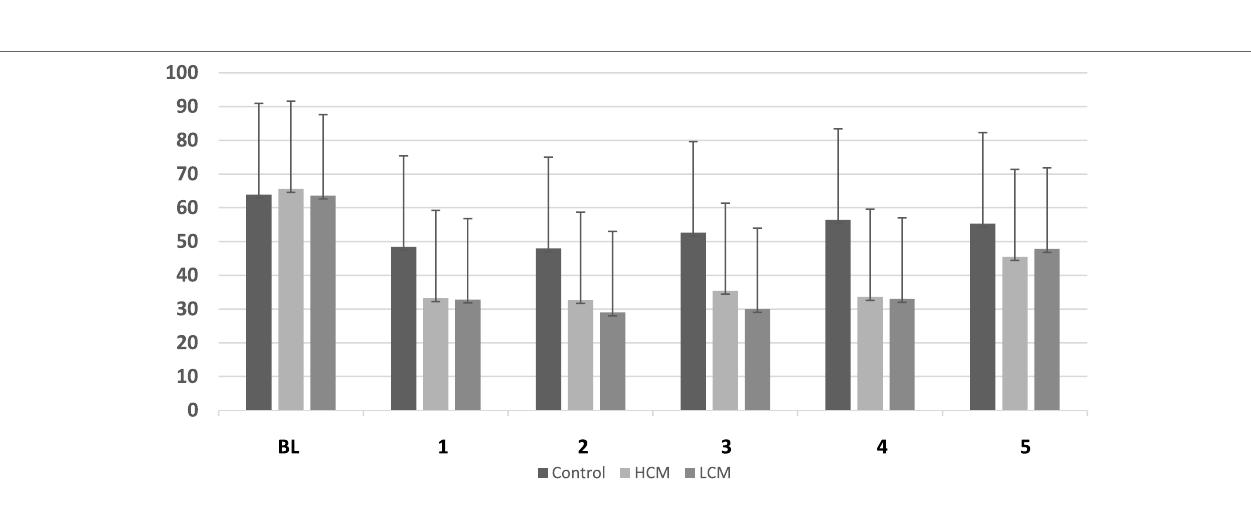
FigUre 2 | Heat pain intensity during three study conditions (mean ± SEM). Asterisks represent differences between the two virtual reality (VR) conditions and control within two adjacent time points. LCL, low cognitive load VR; HCL, high cognitive load VR. ** p < 0.01, *** p <